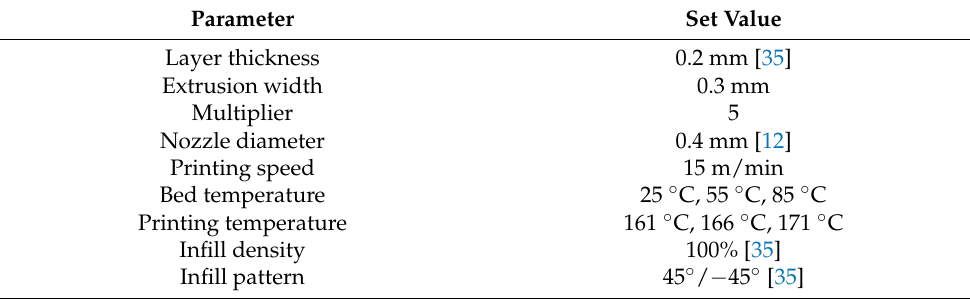
Figure 1. In-house-built 3D pellet printer [34] with modifications: ( a ) SLS 3D-printed cone, ( b ) large milled slot for liquid cooling, ( c ) Teflon plate for insulation, and ( d ) single profile extruder screw. The pellet printer is operated with “Pronterface” software. “Pronterface” executed the G-codes for the sliced files in “Stl” format of ASTM D638 type IV dog bone. For performing the slicing, software named “Slic3r” was utilized, which also developed the G-codes. The printing parameters are provided in Table 3. Table 3. Parameters for 3D printing (FFF).